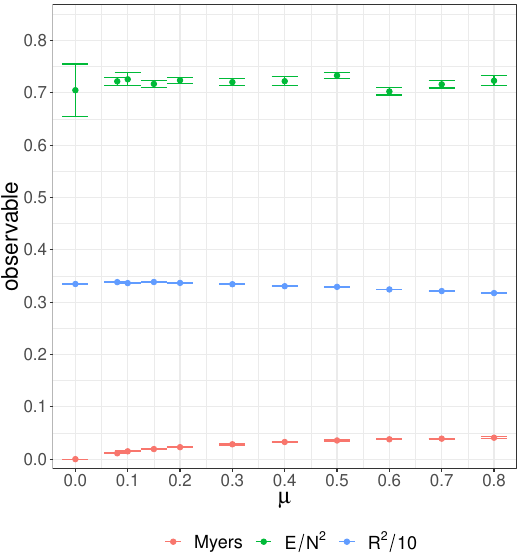
Figure 8 . The dependence of a few observables on µ at T = 0 . 4 , N = 16 , L = 24 . Data points at µ = 0 for the same parameters are from [13]. We observe that the BMN energy for finite µ is contained within the error bars of the BFSS energy and also the other observables approach the BFSS values for µ → 0